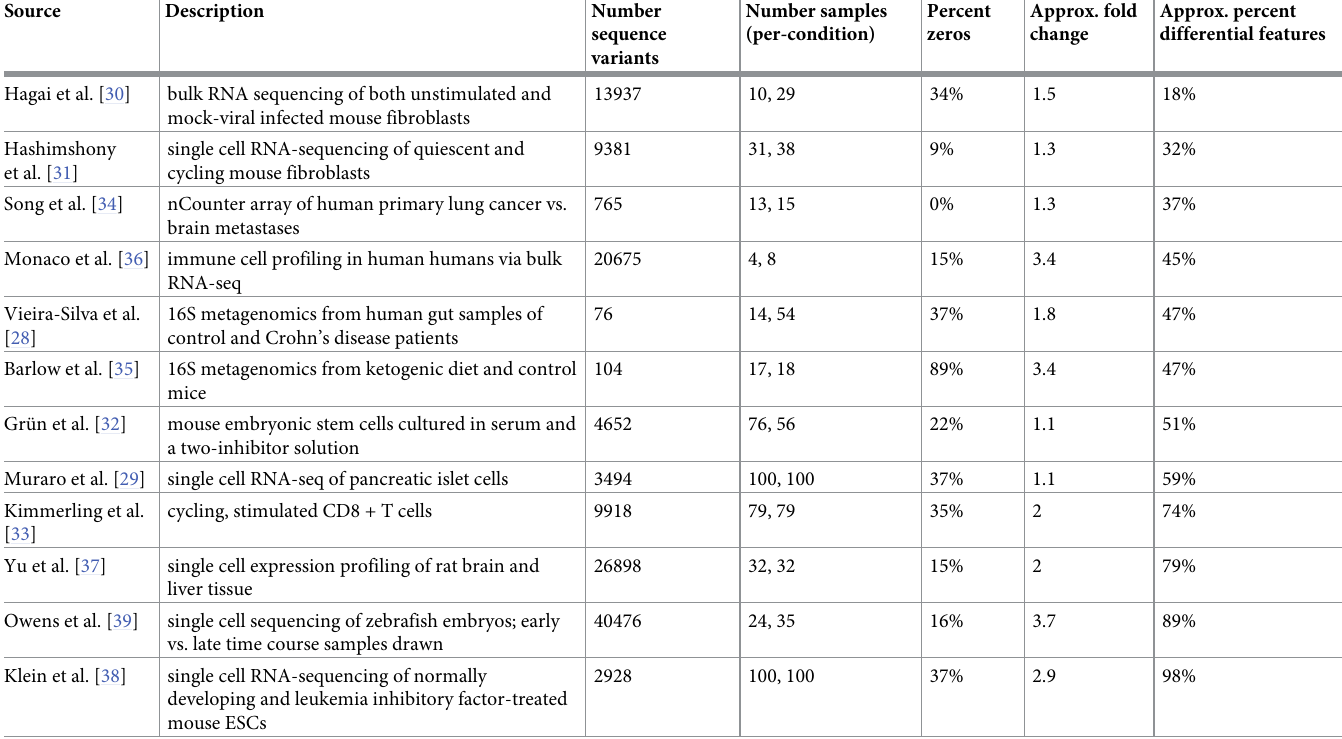
Table 4. Overview of real data sets. Real 16S metabarcoding, bulk RNA-seq, and single cell RNA-seq data sets corresponding to the abundances shown in Figs 3 and 4. The estimated percent differential features are those significantly differential to a negative binomial GLM in the nominal